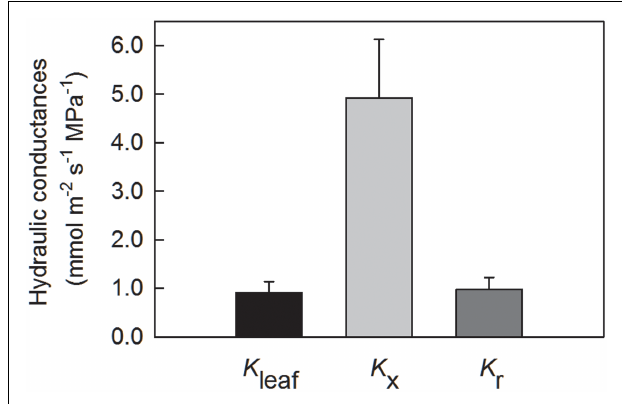
FIGURE 4 | Leaf hydraulic conductances for G. lingulata , normalized by leaf blade area and leaf length. Data are means ± 1SE; N = 7 plants.